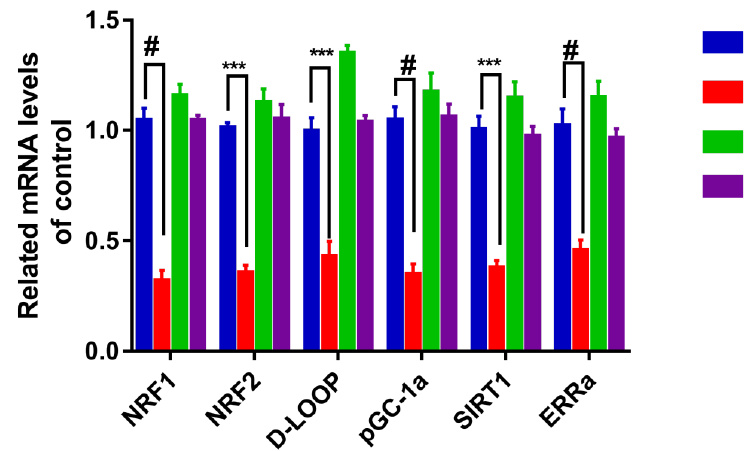
Figure 9. Effect of G6 treatment on mRNA expression of the SIRT1/ pGC-1a pathway in HaCaT cells. HaCaT cells were pretreated with G6 (10 μM) in MEM medium for 24 h. Then, the cells were exposed to UVA (30 J/cm 2 ) irradiation. mRNA levels were analyzed by RT-PCR as described in Section